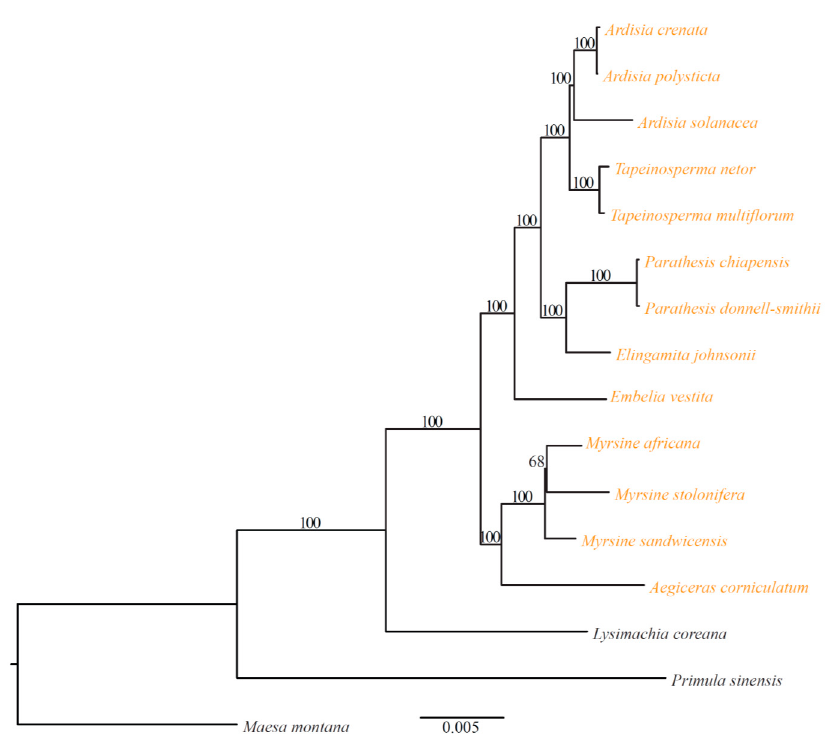
Figure 3. Maximum likelihood (ML) phylogenetic tree of Myrsinoideae based on 78 protein-coding genes. Numbers on the branches are bootstrap values. Species in the Myrsinaceae s.str. clade is indicated by yellow.